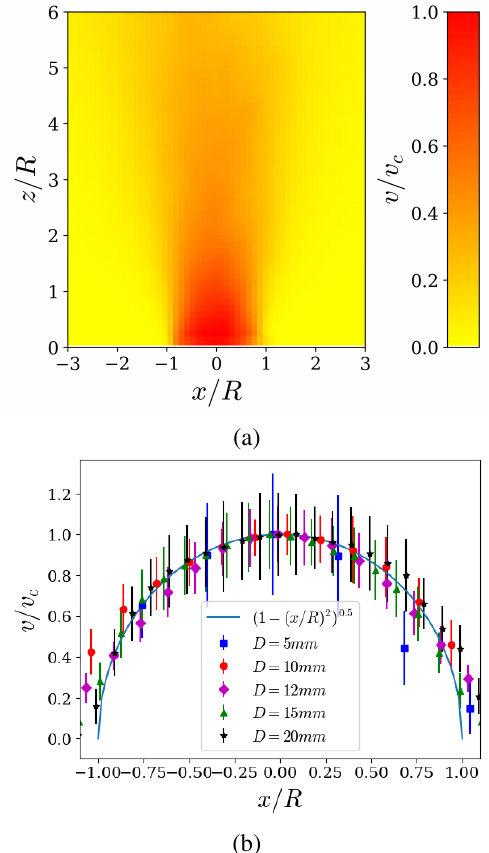
Figure 5. (a) Normalised velocity field for D = 20 mm for co- hesive grains, l c = 2 . 6 mm . (b) Normalised velocity profile at the orifice. v c is the velocity at the center of the